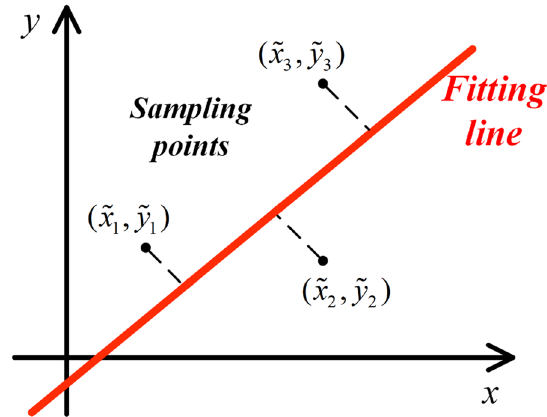
Figure 2 The principle of the LS method